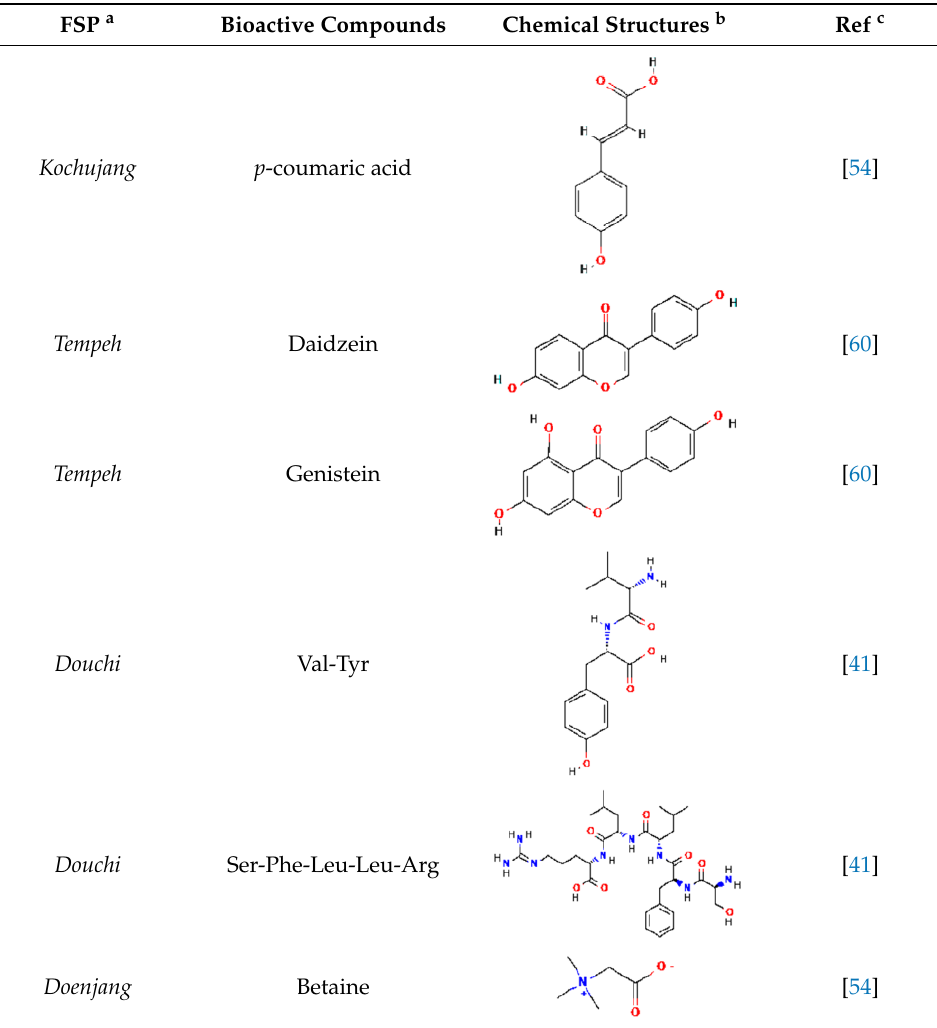
Table 8. The responsible molecules for the glucoregulatory activity in